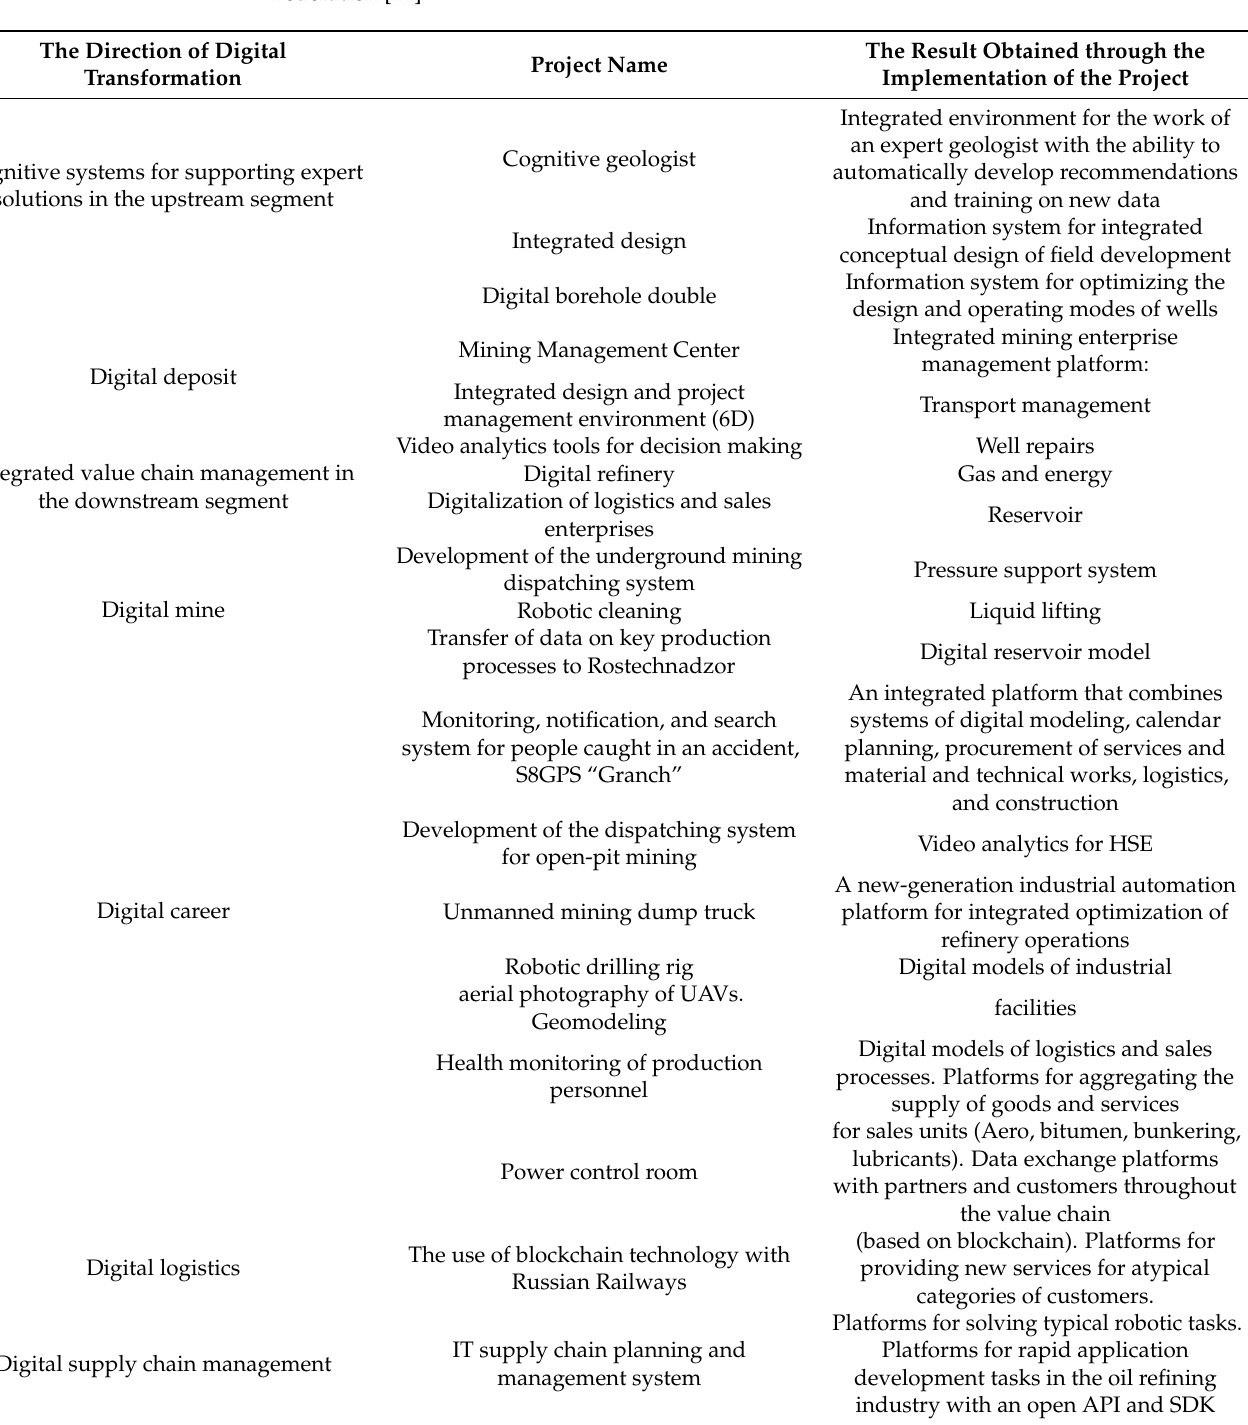
Table 5. Pilot projects on digitalization of the oil and gas complex and the coal industry of the Russian Federation